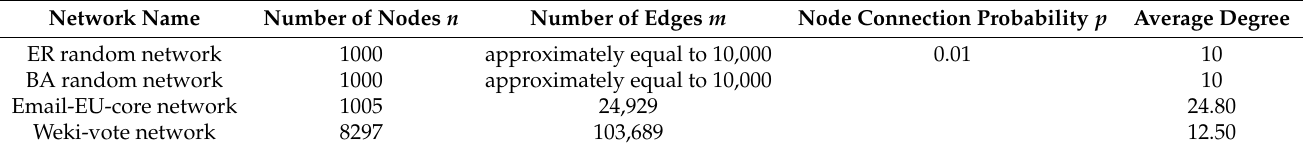
Table 1. Network